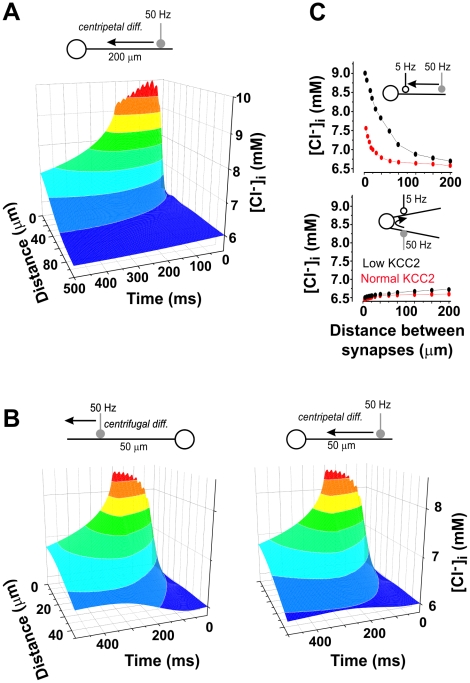
Redistribution of intracellular Cl− through electrodiffusion.
A. Chloride influx through a single GABAAR synapse (located at 200 µm from the soma) activated at 50 Hz produced a substantial longitudinal gradient in [Cl−]i extending 60 µm on each side of the input. B. Chloride influx through a single GABAAR synapse (this time located at 50 µm from the soma) produced a longitudinal gradient which is steeper toward the soma (centripetal diffusion) than away from the soma (centrifugal diffusion). For this simulation, we used dendrites with constant diameters to ensure that the difference between left and right panels is due to the sink effect of the soma and not to the conical shape of the dendrite. We also lengthened the dendrite and increased the number of compartments to 60 compared to the cell geometry summarized in Fig. 1. C. Spread of Cl− entering through one synapse (activated at 50 Hz) to a second “test” synapse (activated at 5 Hz) at varying inter-synapses distances was measured for normal and low (10%) KCC2 levels. Both synapses were activated simultaneously. For synapses positioned on the same primary dendrites (upper panel), the test synapse experienced a sizeable increase in [Cl−]i, especially when KCC2 was reduced, but there was no appreciable spread of Cl− between synapses located on different primary dendrites (lower panel).